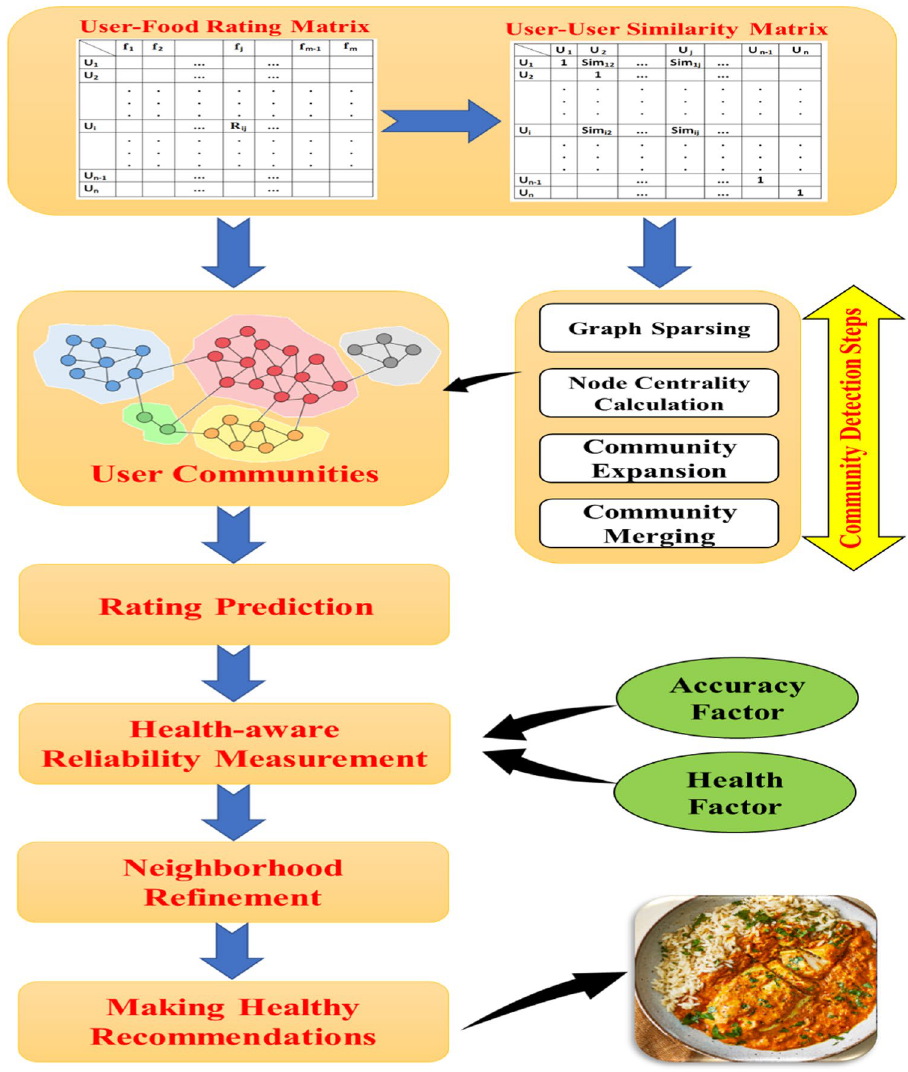
Fig. 1 The general schema of the developed FRSHR